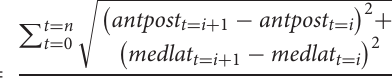
the measurement duration varied, data had to be relativized over the test duration (n) using the formula